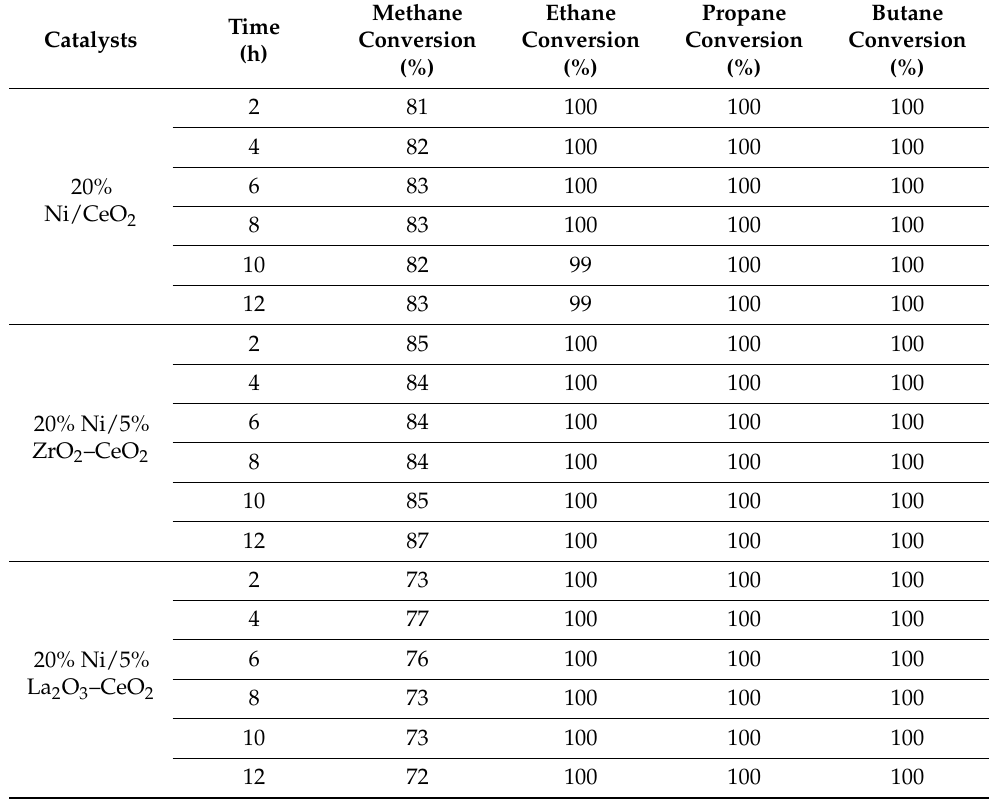
Table 7. Conversion values of the hydrocarbons obtained in the stability tests in the oxy-steam reforming of liquefied natural gas (LNG), performed over 12 h time-on-stream using supported nickel